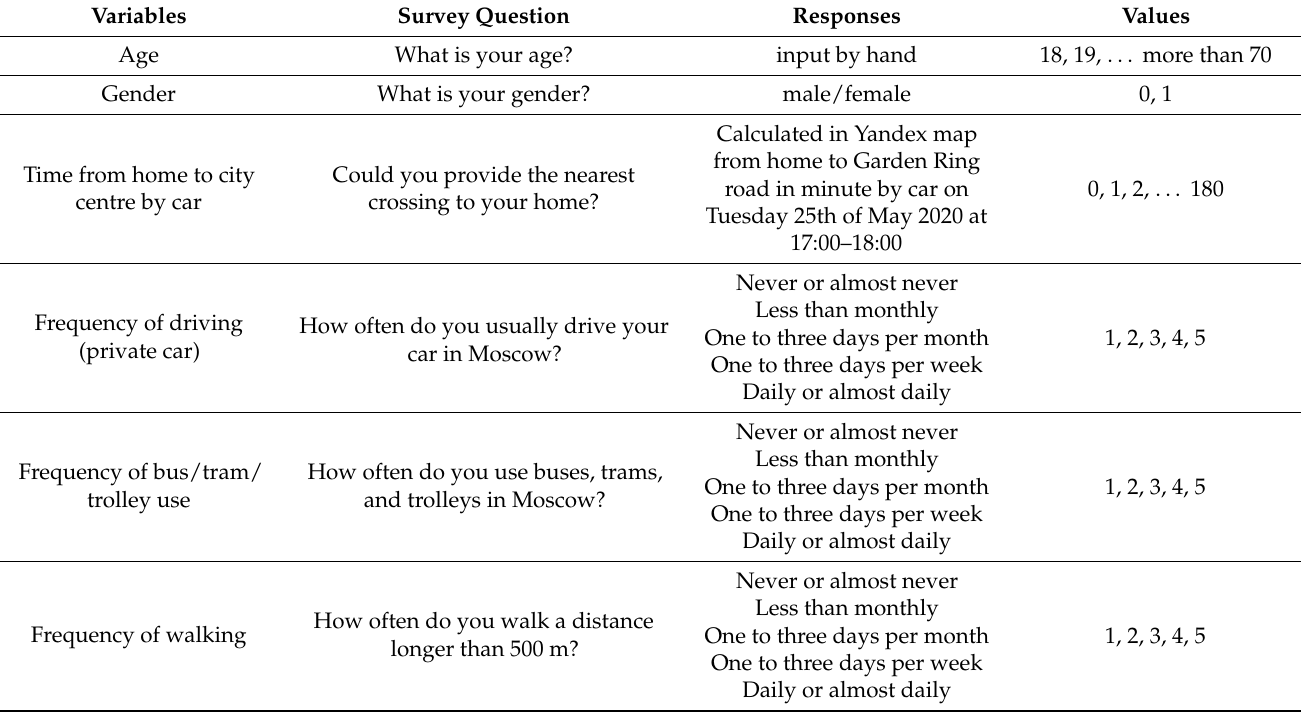
Table 3. Independent variables chosen for ordinal logistic